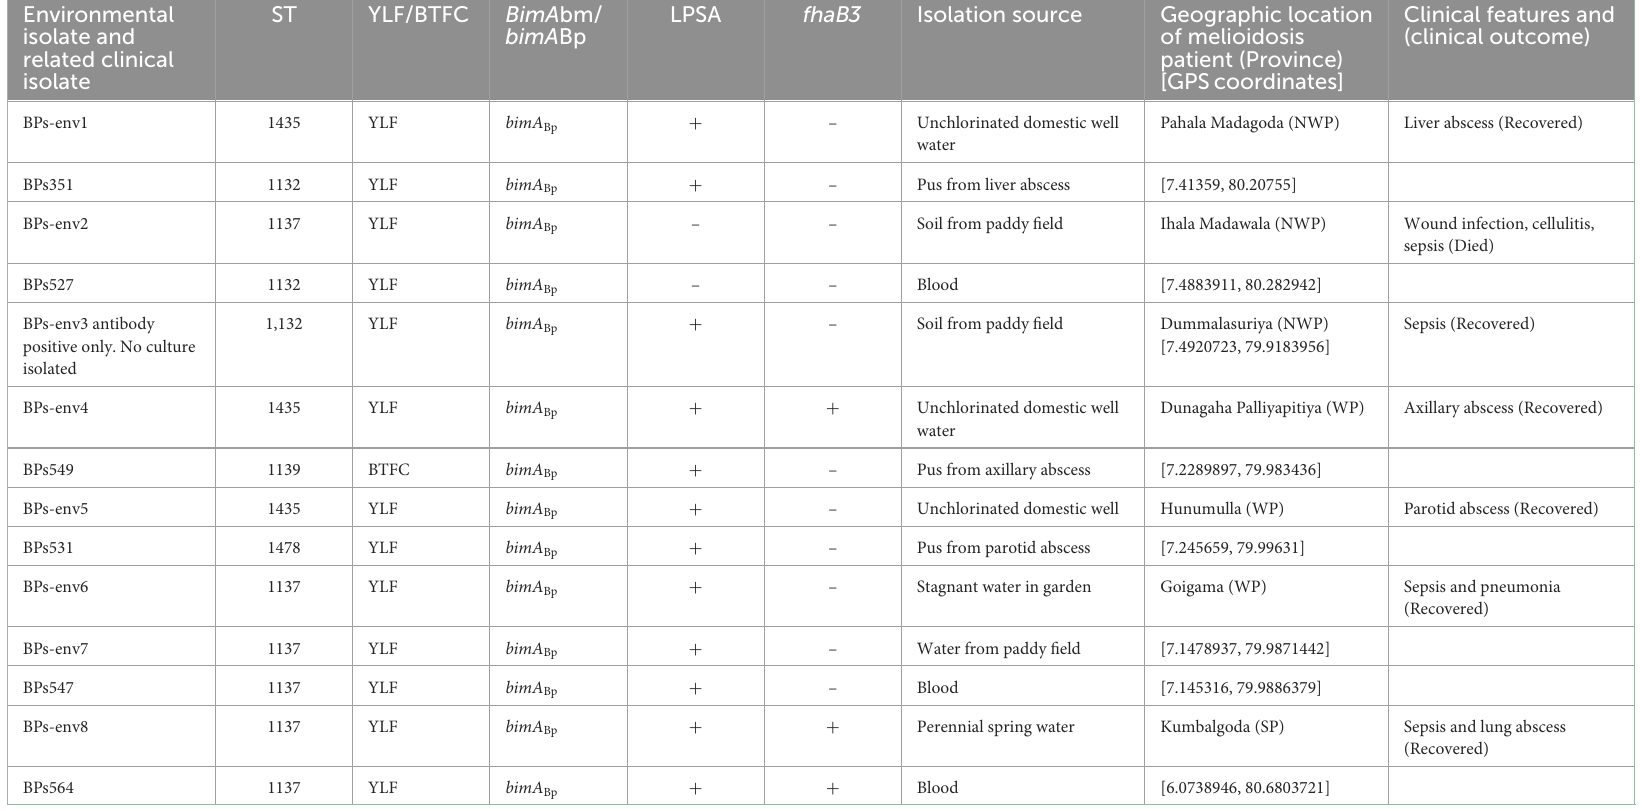
TABLE 1 Description of genotypes of environmental and corresponding clinical isolates, isolation source, geographic location, and clinical presentations. Environmental isolate and related clinical